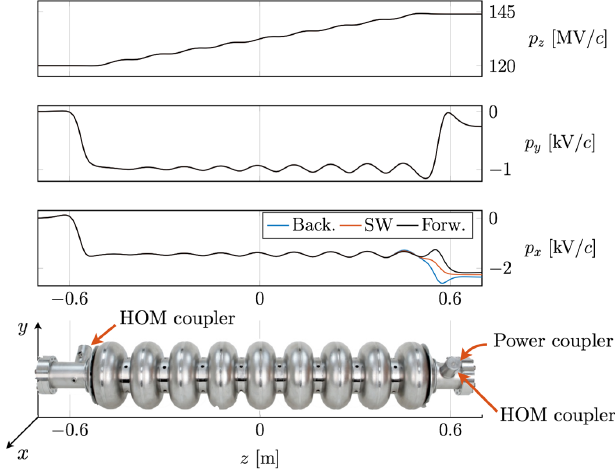
FIG. 1. Tracking results for a particle which enters a TESLA cavity on axis with an initial beam energy of 120 MeV. Plotted are the longitudinal (top), vertical (mid) and horizontal (bottom) momentum as a function of the longitudinal coordinate z . The accelerating gradient is 24 MV = m. The significant change of transverse momenta at the coupler positions are related to coupler kicks. The sinusoidal variation inside the cavity is related to axially symmetrical rf focussing. Tracking is calculated for a purely forward traveling wave (black), a standing wave (red), and a backward wave (blue). Only the downstream horizontal coupler kick depends on the mode of cavity operation.